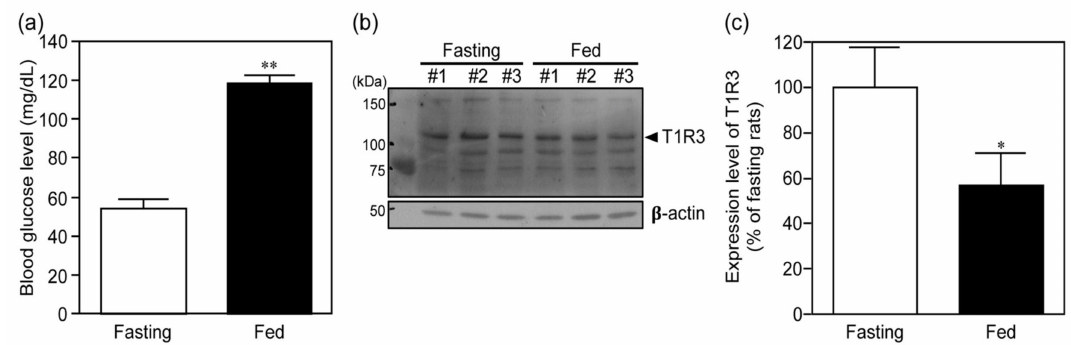
Figure 1. Blood glucose levels and expression of T1R3 in the pancreas in rats under fasting and fed conditions. After 18 h-fasting with or without subsequent 4 h-fed treatment of rats, their blood glucose levels ( a ) and expression of T1R3 in the pancreas ( b , c ) were measured. The results shown in panel c were obtained based on the band density of T1R3 corrected for by that of ß-actin shown in panel b . In panel b , #1, #2 and #3 are the rat numbers. Each bar represents the mean ± SD for three rats. * p < 0.05 and ** p < 0.001 (vs.